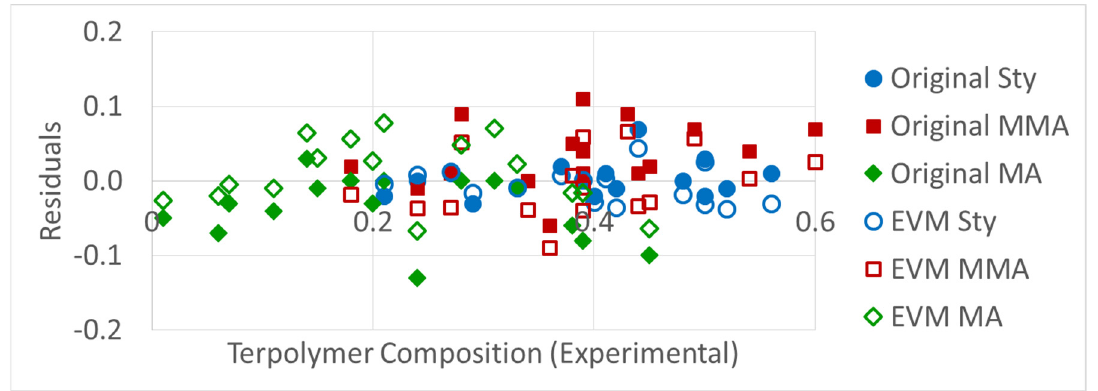
/ MMA / MA terpolymer composition Figure 9. Comparison of residuals for Sty/MMA/MA terpolymer composition predictions. Figure 9. Comparison of residuals for Sty